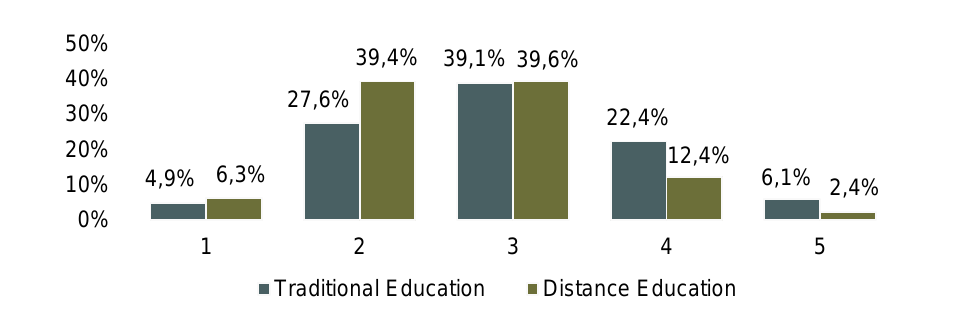
Fig. 4. Courses by Range of the ENADE Concept 2017 Teaching Modality [47].